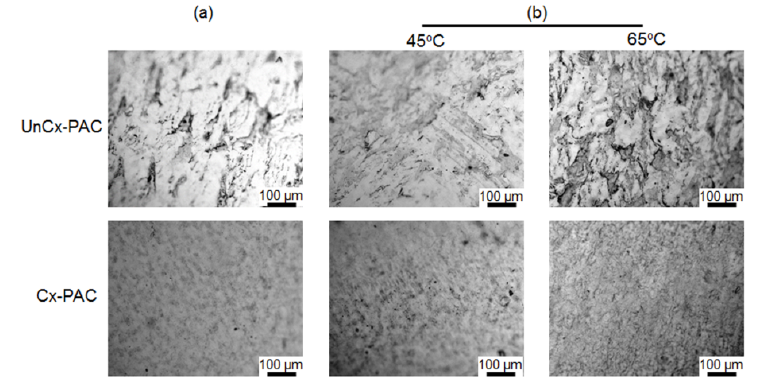
Figure 2. Optical images of UnCx ‐ PAC and Cx ‐ PAC film ( a ) before and ( b ) after thermal treatment at 45 °C and 65 °C.